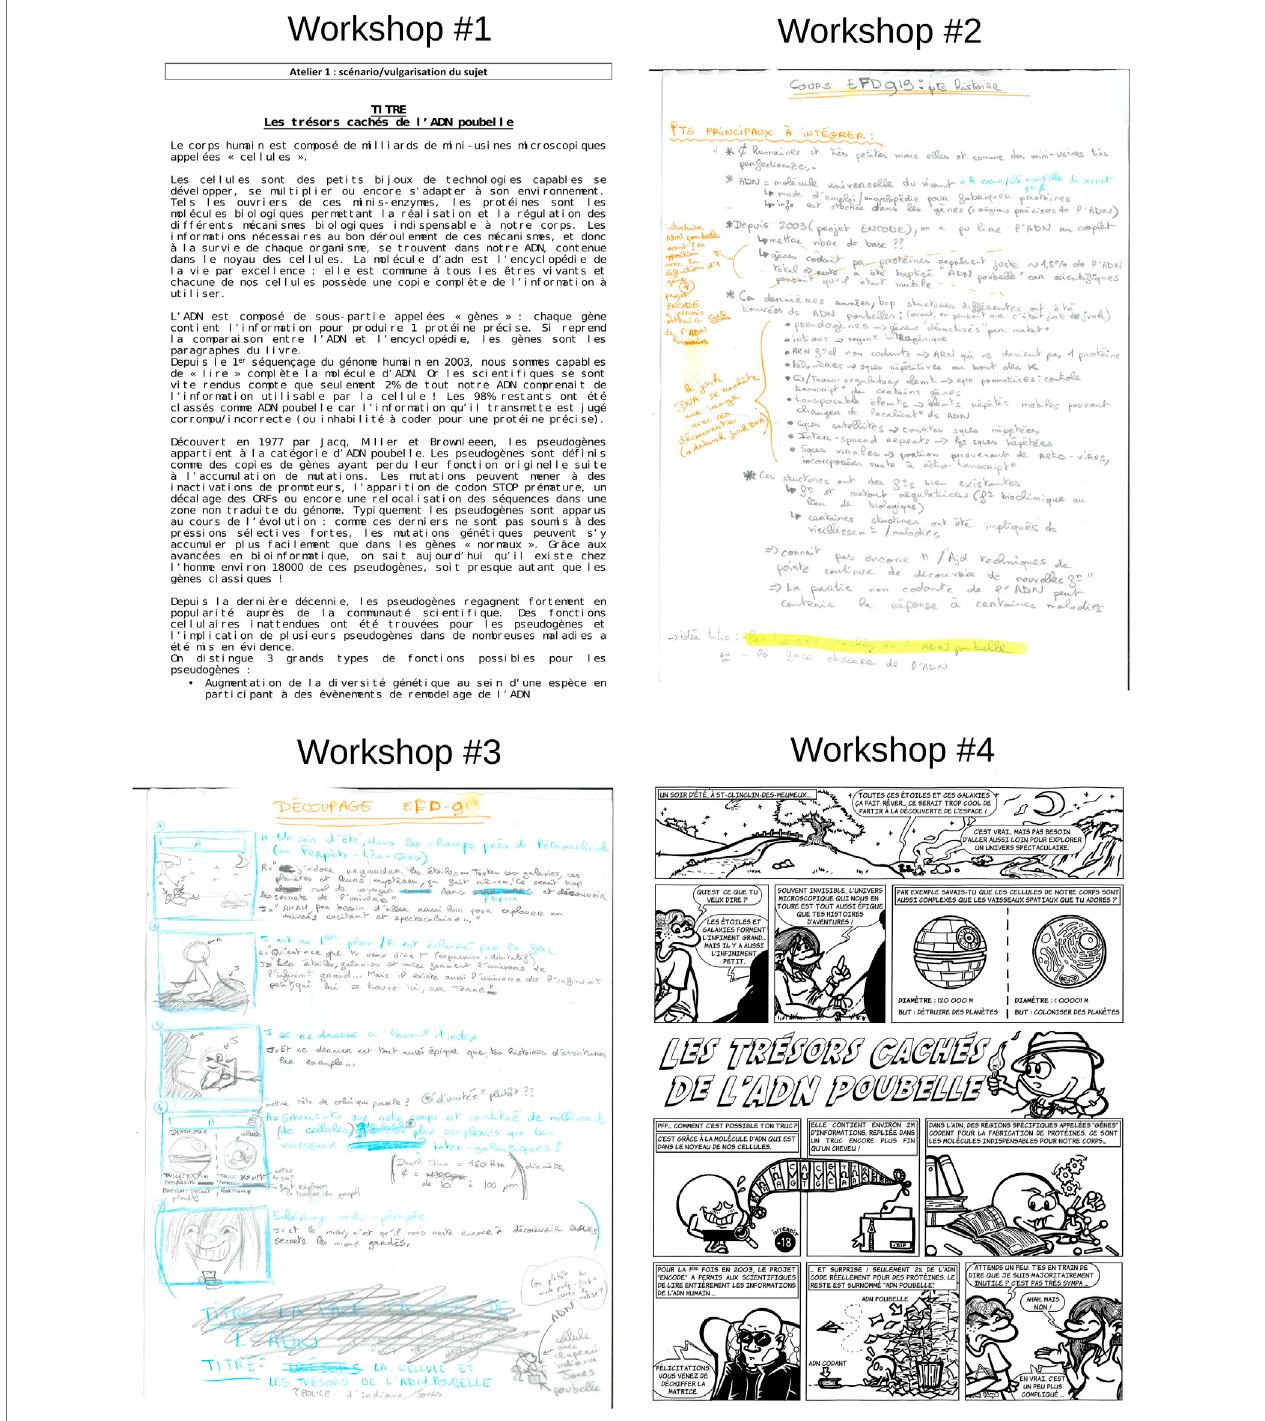
FIGURE2| Secondexampleofthecourseoutcomes:Workshop#1:initialpopularizedtext;Workshop#2: fi rstwrittenscenariobreakdown;Workshop#3:second scenariobreakdownincludingsketches;Workshop#4: fi rstpageofthe fi nalblackandwhitework,latercolorized(JulieFrion,Lestrésorsdel ’ ADNpoubelle- JunkDNA ’ s treasures